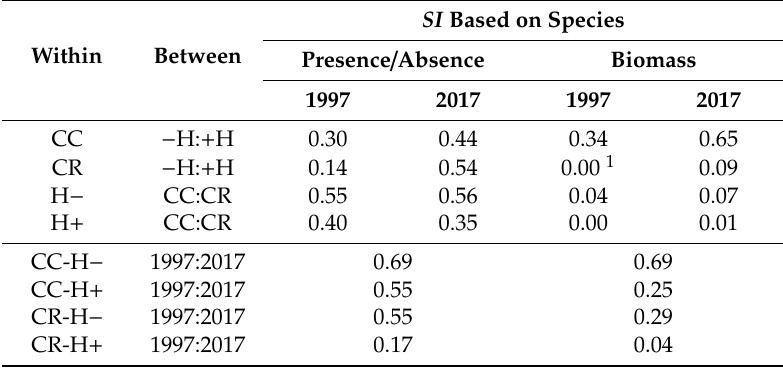
Table 9. Similarity coe ffi cients ( SI ) of weed communities in winter rye fields. SI Based on Species Within Between Presence / Absence Biomass 1997 2017 − H: +